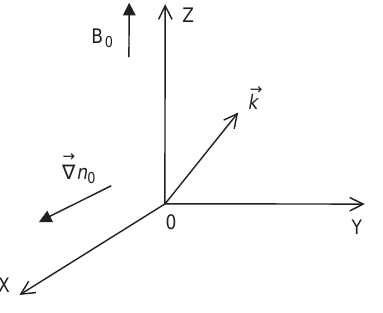
Fig. 9. The plasma